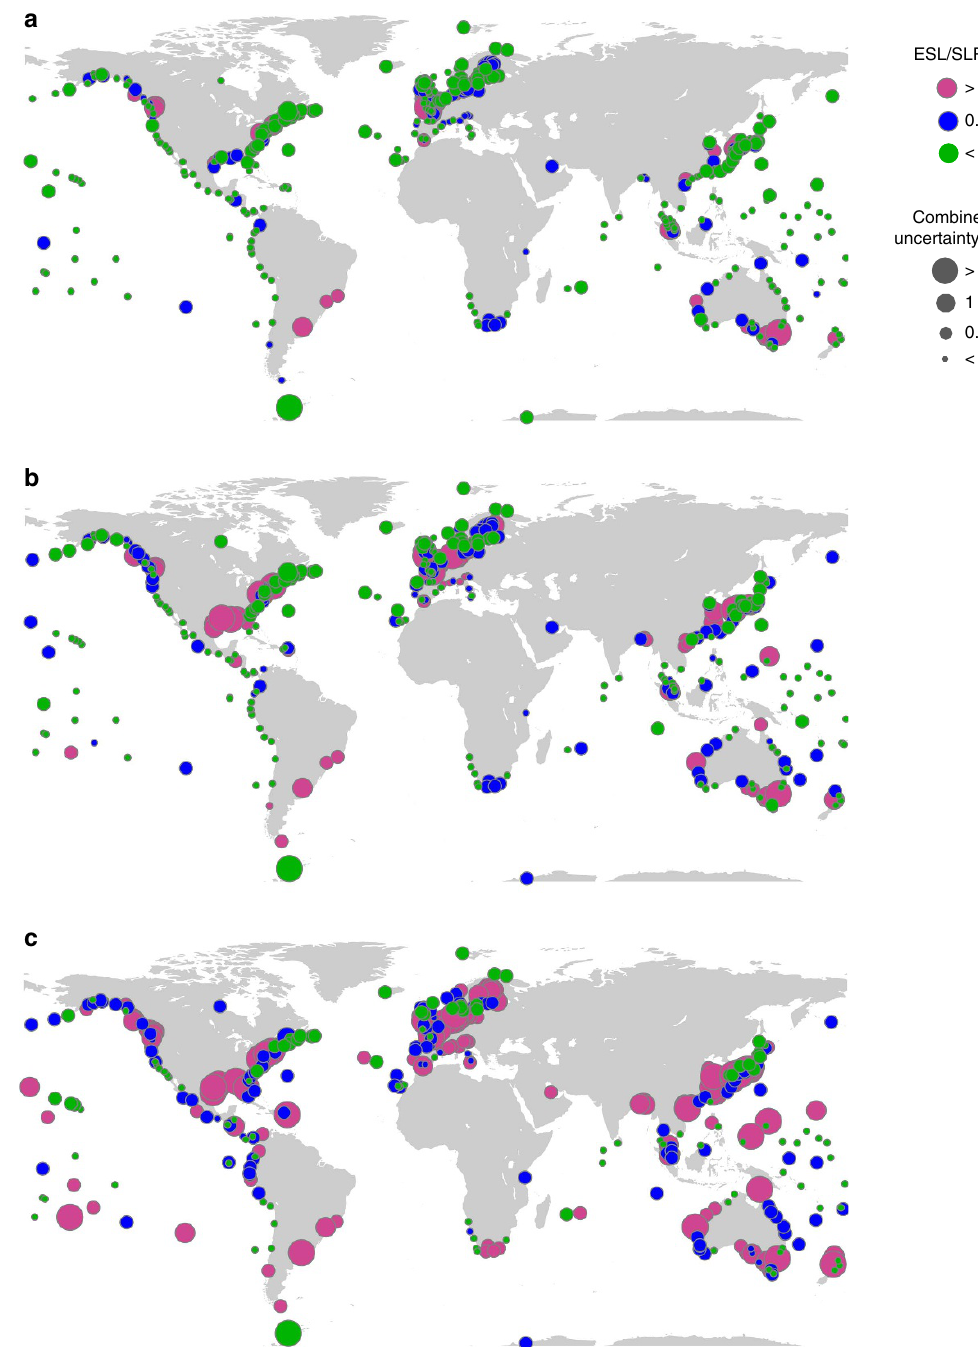
Figure 6 | Combined regional sea-level rise and extreme sea level uncertainties. Combined uncertainties (5–95% range; see circle sizes for magnitude) in future sea-level rise (SLR) projections (Representative Concentration Pathway 4.5 scenario and 2081–2100 mean minus 1986–2005 mean) and present- day extreme sea level estimates and their relative importance (see colour coding) for the ( a ) 10-year, ( b ) 100-year and ( c ) 1,000-year return